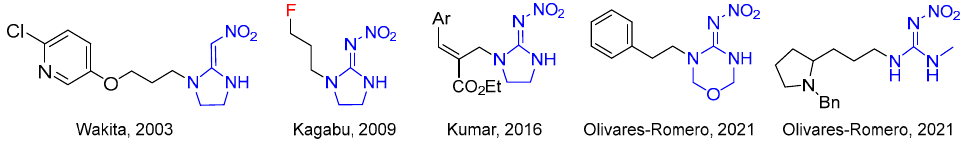
Figure 2. The modi fi cations of linkages of neonicotinoid insecticides [13–17]. Figure 2. The modifications of linkages of neonicotinoid insecticides